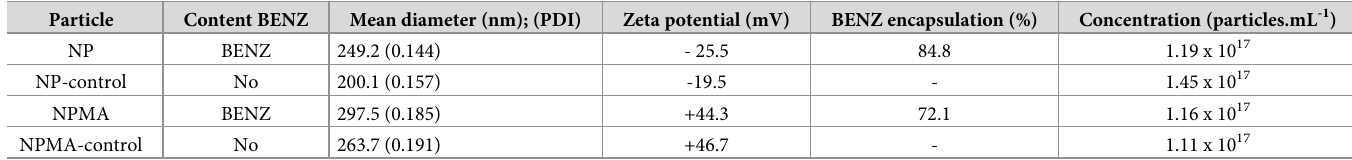
Table 1. Initial values of mean diameter (nm), polydispersity index (PDI), zeta potential and encapsulation efficiency of suspensions: NP (content benzocaine), NP- control, NPMA (content benzocaine) and NPMA-control (n = 5). Particle Content